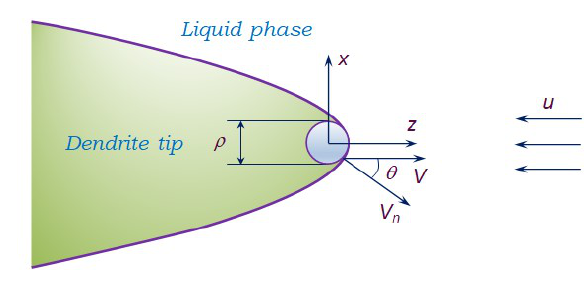
Figure 1. A sketch of dendritic tip with incoming melt